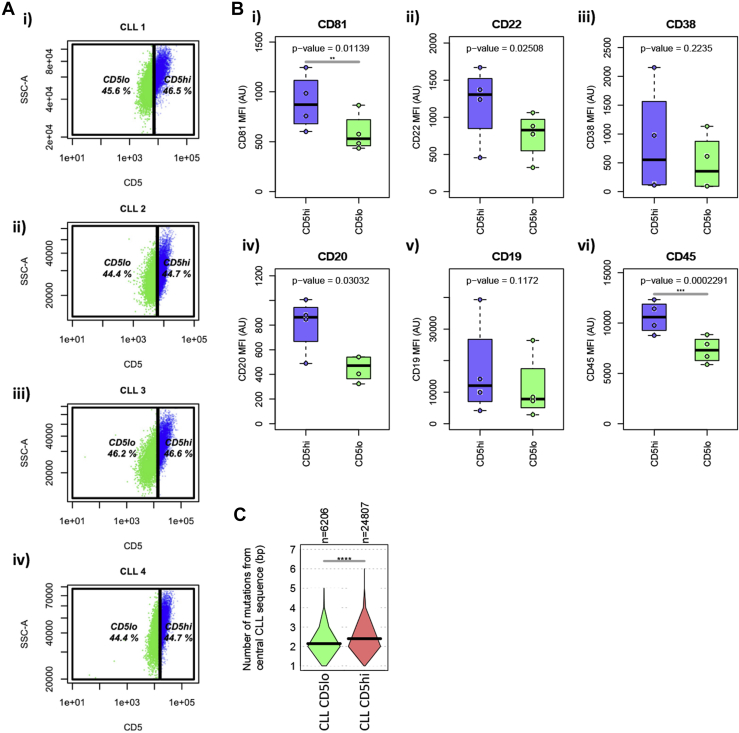
Testing the cell surface expression differences between CD5high and CD5low from 4 CLL patients. (A) The gating strategy used for identification of CD5high and CD5low peripheral blood B cells from PBMC samples, where CD5high cells were defined as greater than 1.05 × (median CD5 fluorescence in the CD19+CD45+ lymphocytes, green gate) and CD5low were defined as less than 0.95 × (median CD5 fluorescence in the CD19+CD45+ lymphocytes, blue gate). (B) The corresponding boxplots of the mean of fluorescence (MFI) between the CD5high and CD5low B-cell populations for (i) CD81, (ii) CD22, (iii) CD38, (iv) CD20, (v) CD19, and (vi) CD45. p values were calculated as paired two-tailed t-tests. (C) Violin plots of the numbers of mutations in the CD5high and CD5low BCR sequences from the sequencing data in Figure 2. **** p value < 10−6. Flow-cytometric fluorescence intensities of fluorophore-conjugated antibodies against a set of CLL-associated B-cell surface antigen (namely CD81, CD22, CD38, CD20, CD19, and CD45) were used to quantify cell-surface expression in the CLL clone. Notably, the mean of fluorescence (MFI) for the expression of both CD45 and CD81 by circulating CLL B cells was significantly lower for CD5low B cells compared to CD5high B cells (paired t-test p values of 0.011 and 0.00023, respectively; Supplementary Fig. E7). CD45 is normally found on all leukocytes, where previous studies show CD45 plays a positive regulatory role during B-cell receptor signaling [13]. CD81 is usually expressed at high levels in normal germinal center B cells, and associated with mutated CLL. This is in agreement with our data, as the CD5high CLL B cells are associated with a higher number of mutations within the CLL clone as well as higher CD81 levels.